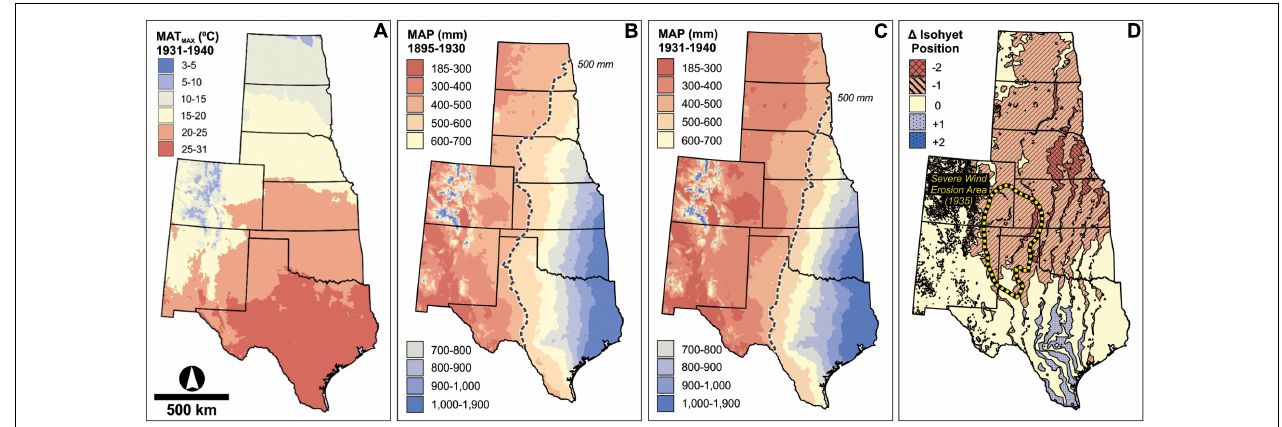
FIGURE 2 | (A) The latitudinal gradient of northern to southern grasslands generally follows mean annual maximum temperature (MAT MAX ). (B) From 1895 to 1930 the position of the longitudinal mean annual precipitation (MAP) gradient generally corresponds to the short-to-tallgrass transition, but (C) during 1931 to 1940 MAP over the plains was significantly drier, and (D) this gradient was shifted eastward ∼ 250 km compared to MAP in the previous 36-year period, encompassing the largest extent of recognized severe wind erosion during the Dust Bowl (Worster, 1982; Cunfer, 2005). Temperature and precipitation data is derived from PRISM Historical Past time series datasets (PRISM Climate Group, Oregon State University, http://prism.oregonstate.edu, created October 3,